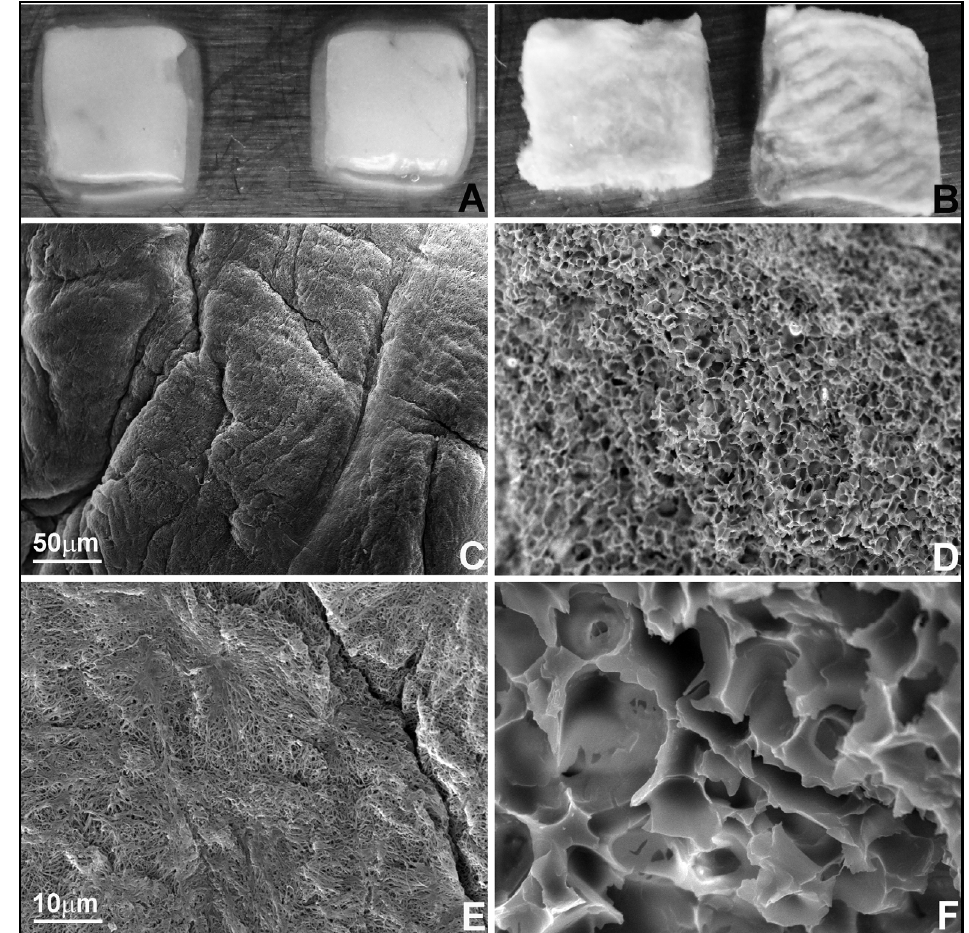
Figure 1. Macro-, micro-, and submicrographic comparison of fresh and lyophilized PRF structure. ( A , B ) are macrophotographs of fresh and lyophilized Platelet-rich fibrin (PRF) preparations, showing cell-free preparations on the left, while the preparations on the right contained red blood cells; ( C – F ) are scanning electron micrographs at 300-fold magnification ( C , D ) and 2000-fold magnification ( E , F ). ( A , C , E ) are from fresh PRF and ( B , D , F ) are from lyophilized PRF. A scale bar in the left-hand panel serves as a reference for the level of magnification in both